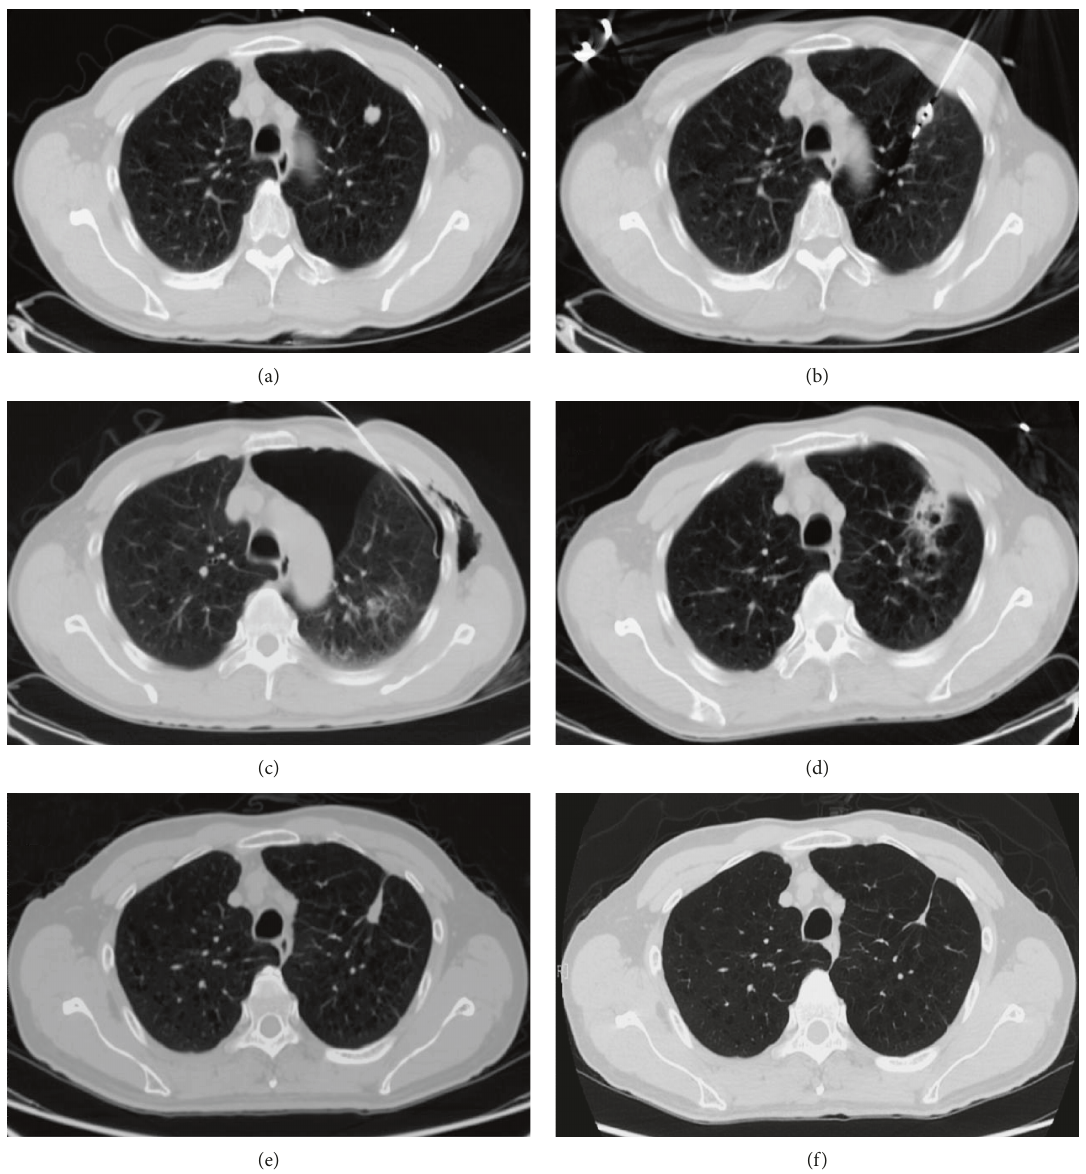
Figure 2: A 62-year-old man with lung metastases from colorectal carcinoma in the left upper lobe with a diameter of 1.5cm (a). Ablation was performed after accurate insertion of MWA probe into the focus of tumor (b). The immediate postoperative CT scan showed pneumothorax (lung compressed approximately 40%), and thoracic cavity closed drainage was conducted immediately (c). The lesion enlarged slightly with ill-de fi ned margin and air- fi lled cavity on one month follow-up (d). During 3 (e) and 6 (f) months follow-up, the lesion was shrunk gradually and replaced by fi brous tissue with no evidence of tumor